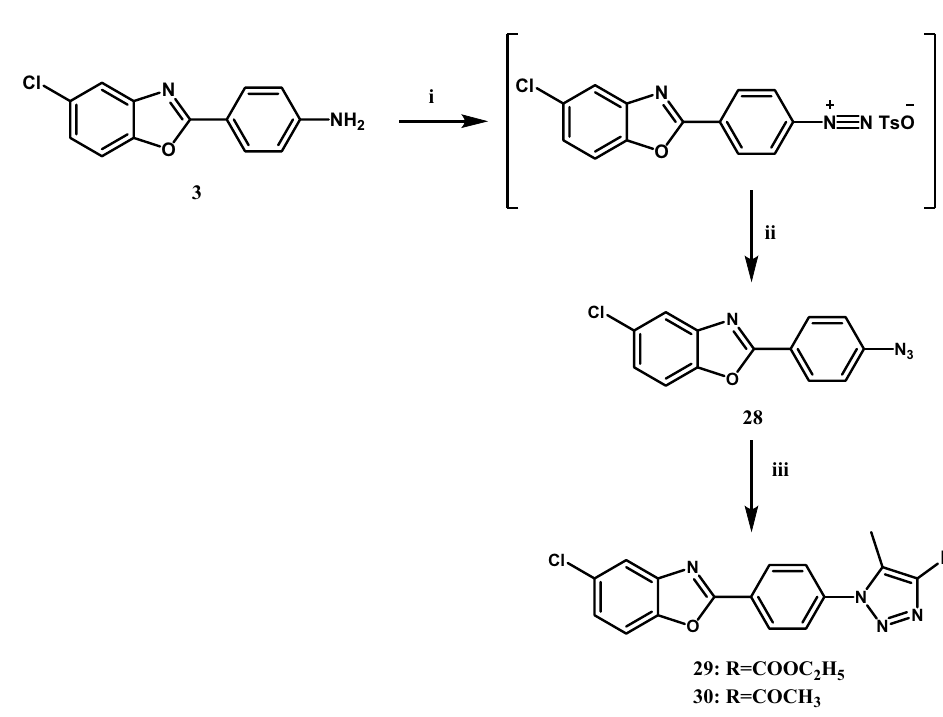
Figure 6. Synthetic scheme of target benzoxazole derivatives 28–30